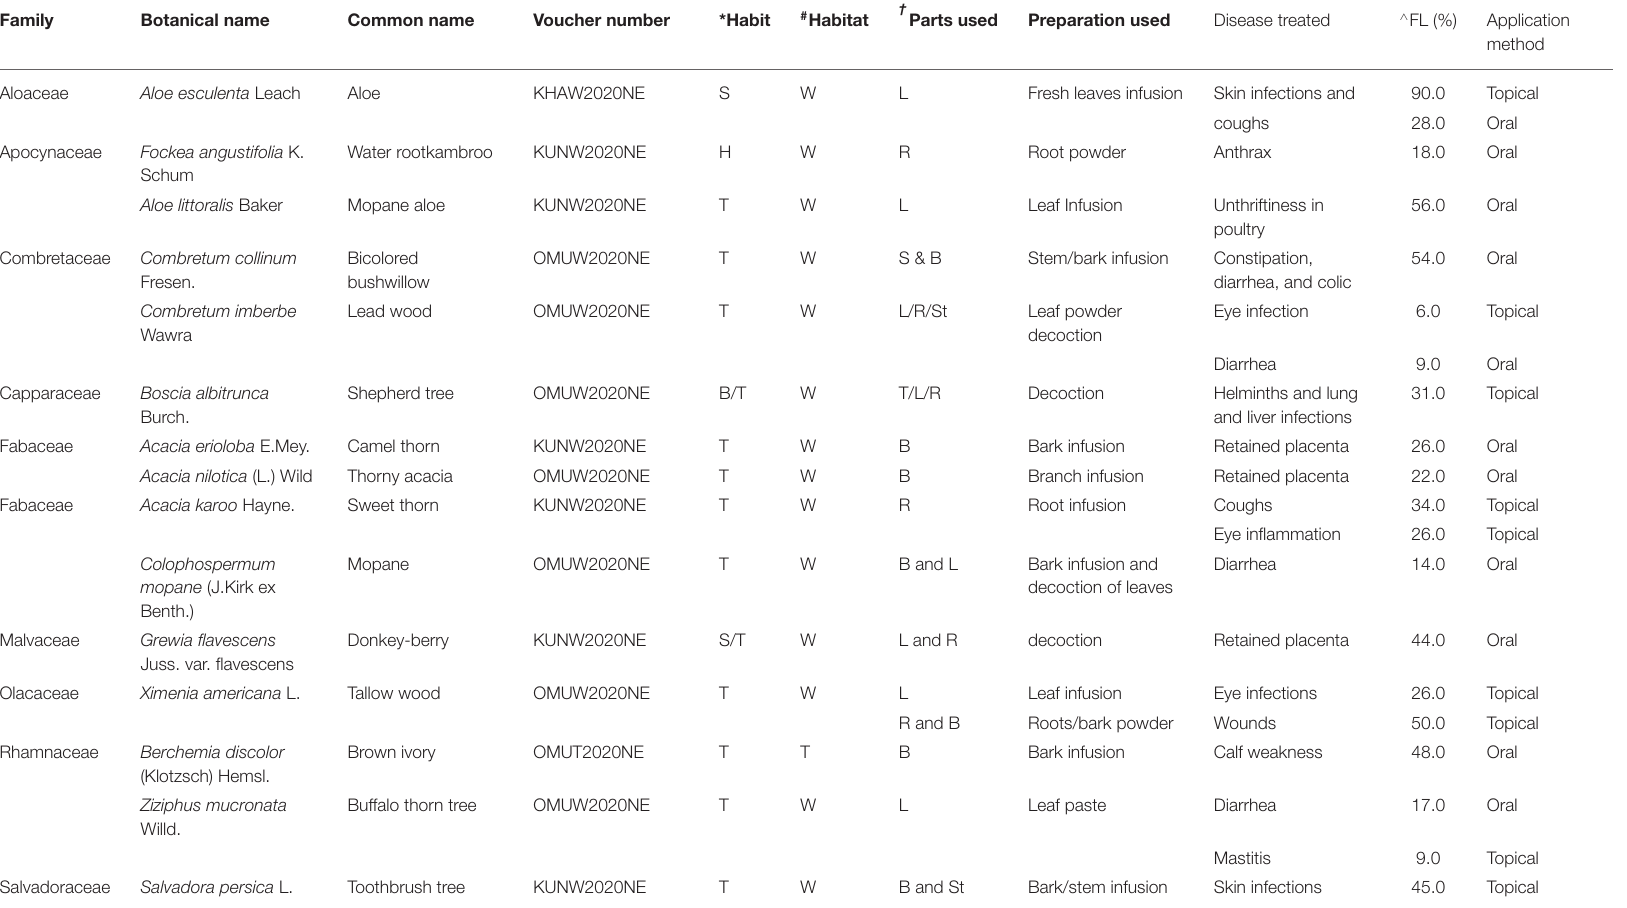
Bark/stem infusion Skin infections 45.0